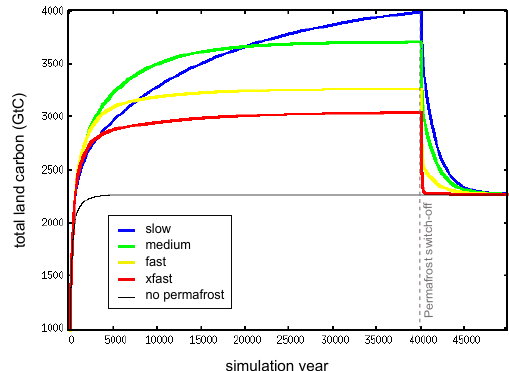
Figure 13. Total land carbon (GtC) for the PI(eq) simulation fol- lowed by a permafrost switch-off at 40k simulation years repre- senting a complete and immediate permafrost thaw, demonstrating the different dynamic behaviour of each dynamic